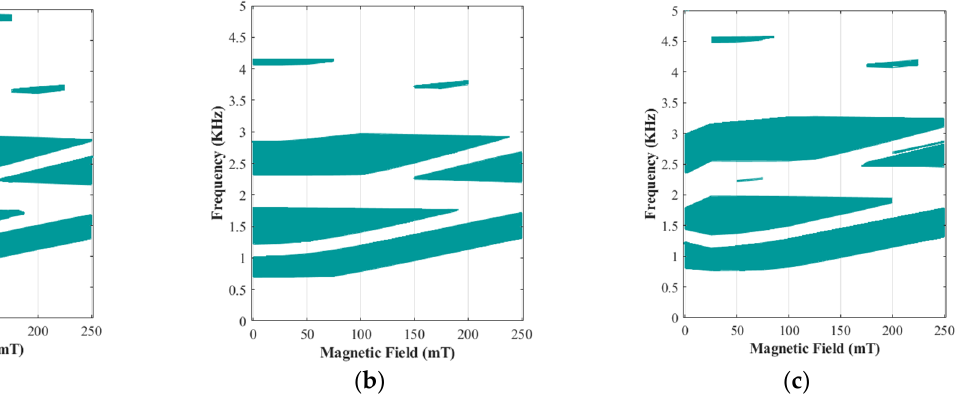
Figure 12. Evolution of active bandgap areas in different magnetic fields (0 < B < 250 mT) with the various iron volume fraction, fixed cylindrical core radius of L / R = 5, and the fixed arm angle θ = 0: ( a ) φ = 6.08%; ( b ) φ = 13.94%; ( c ) φ = 18.48%.